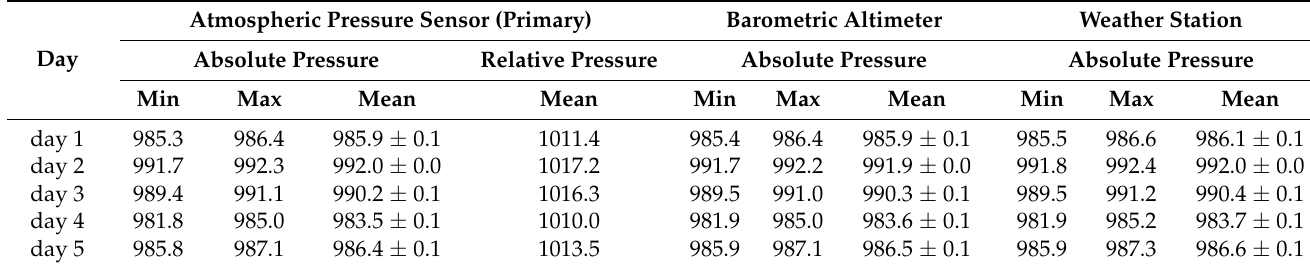
Table 2. Atmospheric pressure (in